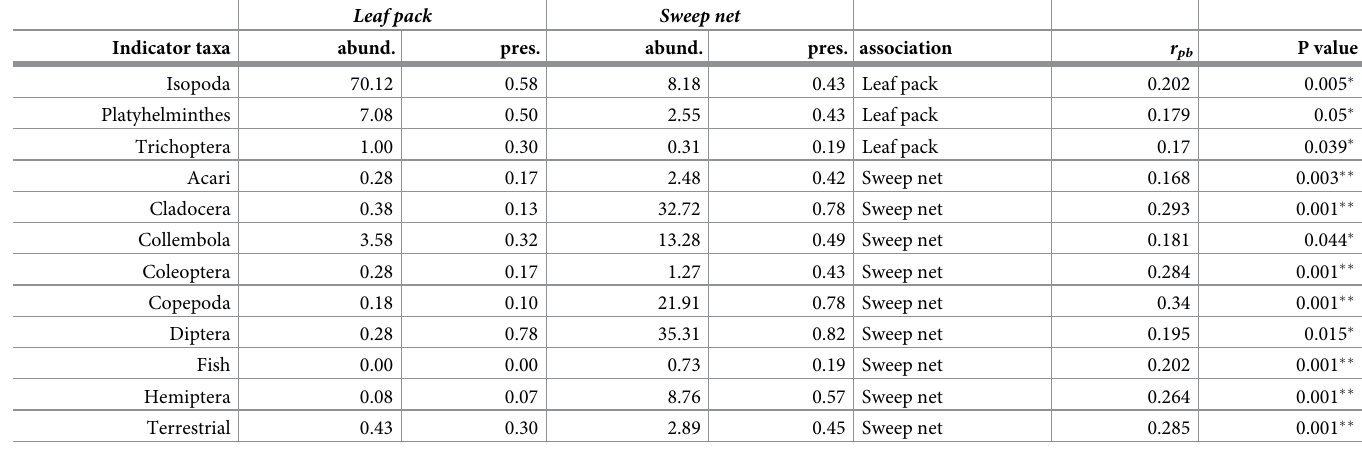
Table 6. Taxa which were significantly associated with a particular sample type, area, or habitat, mean abundance by group (abund.), proportion of samples where taxa was present (pres.), and statistical significance of the association. Leaf pack Sweep net